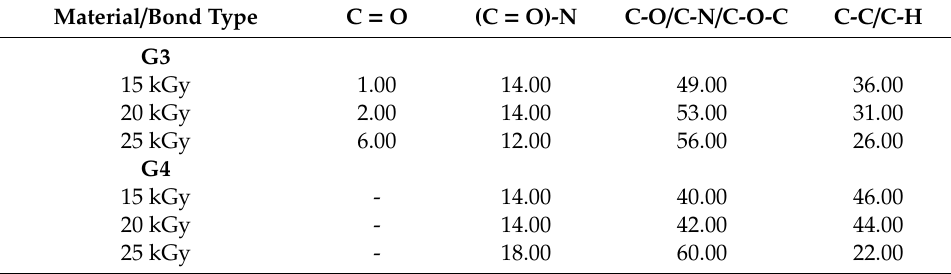
Table 7. Distribution of chemical bonds for both G3 and G4 irradiated hydrogels, as function of irradiation